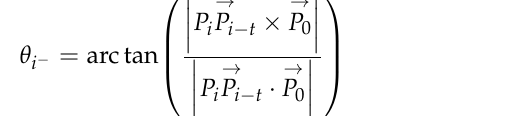
where is the unit horizontal vector and is the length of the chord across the contour point. A jagged contour has a significant effect on the unidirectional chord inclination an- where P 0 = (0, 1) is the unit horizontal vector and t is the length of the chord across the gles, which was studied using the contour at a tangent point, as shown in Figure 8. contour point.